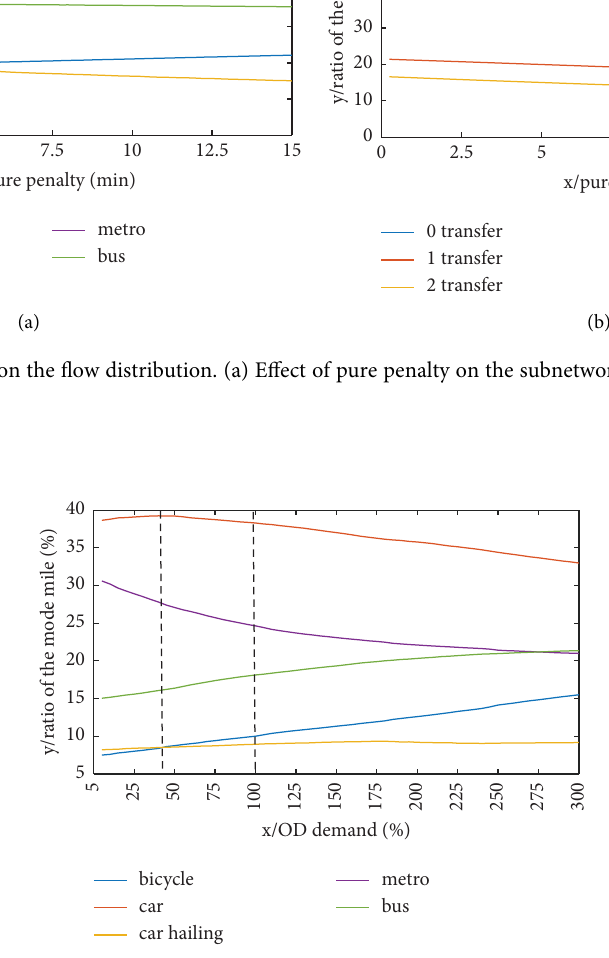
Figure 19: Efect of congestion on the fow distribution.